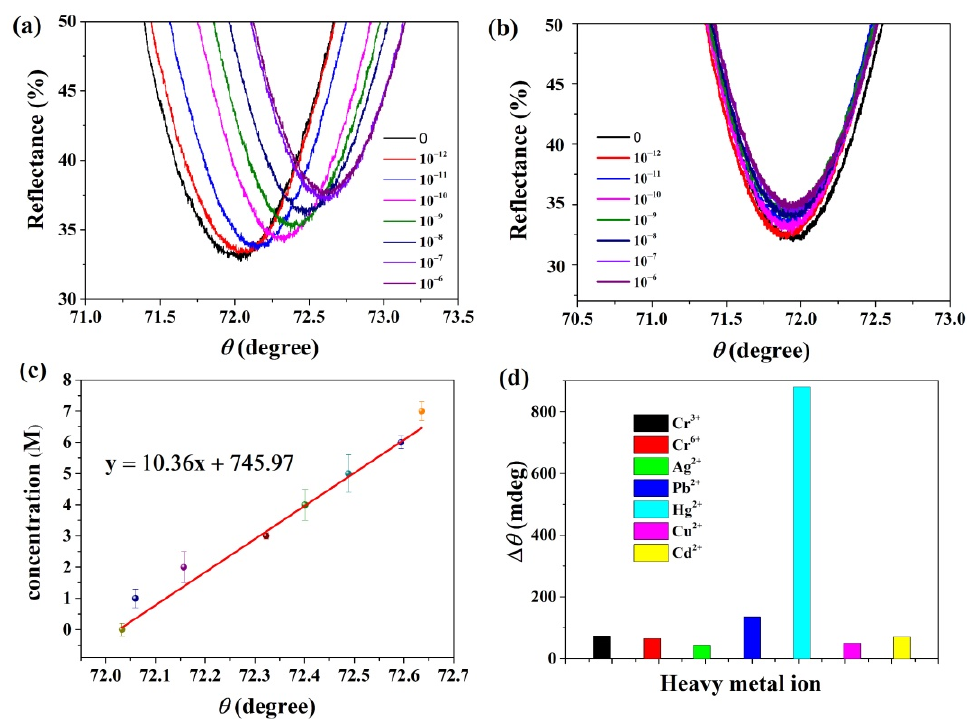
Figure 4. ( a ) The TaS 2 SPR spectra at different concentrations of Hg 2+ from 10 − 12 to 10 − 6 M; ( b ) SPR spectra without TaS 2 at different concentrations of Hg 2+ from 10 − 12 to 10 − 6 M; ( c ) the fitting curve of the incident angle at different concentrations of Hg 2+ from 10 − 12 to 10 − 6 M; ( d ) selectivity of these TaS 2 based Hg 2+